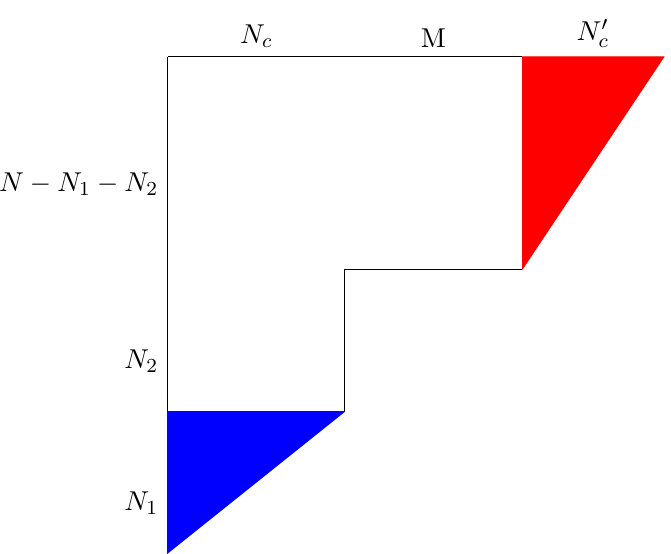
Figure 12 . Young tableau consisting of N 1 fermions in a superstar ensemble with N c giant gravi- tons, N 2 fermions with N c excitation above Fermi sea and N (cid:0) N 1 (cid:0) N 2 fermions with a superstar ensemble of N 0 giants on top of an N c + M c